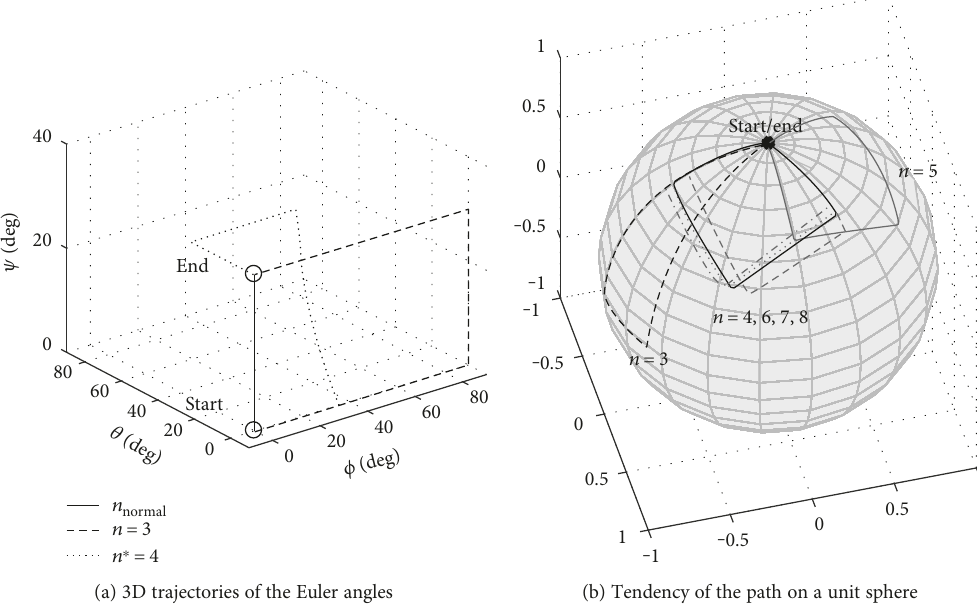
Figure 3: 3D trajectories and tendency descriptions for case